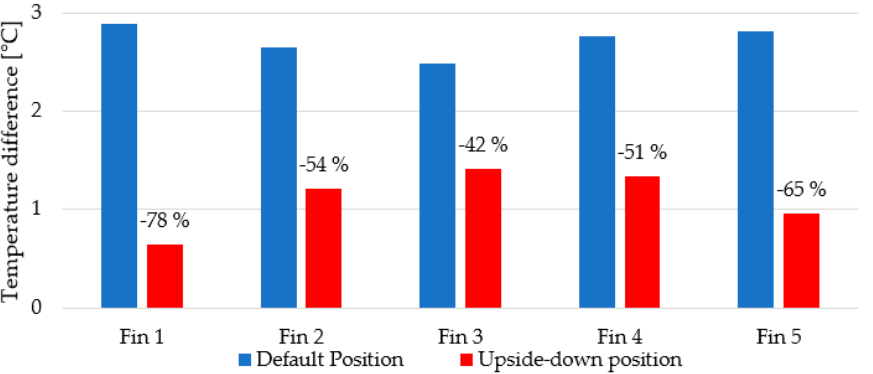
Figure 12. The difference between averaged temperature at the fins’ ends (40–50 mm) and the fins’ beginnings (0–10 mm). The relative drop in percentages of “upside-down” configuration is displayed over red bars.